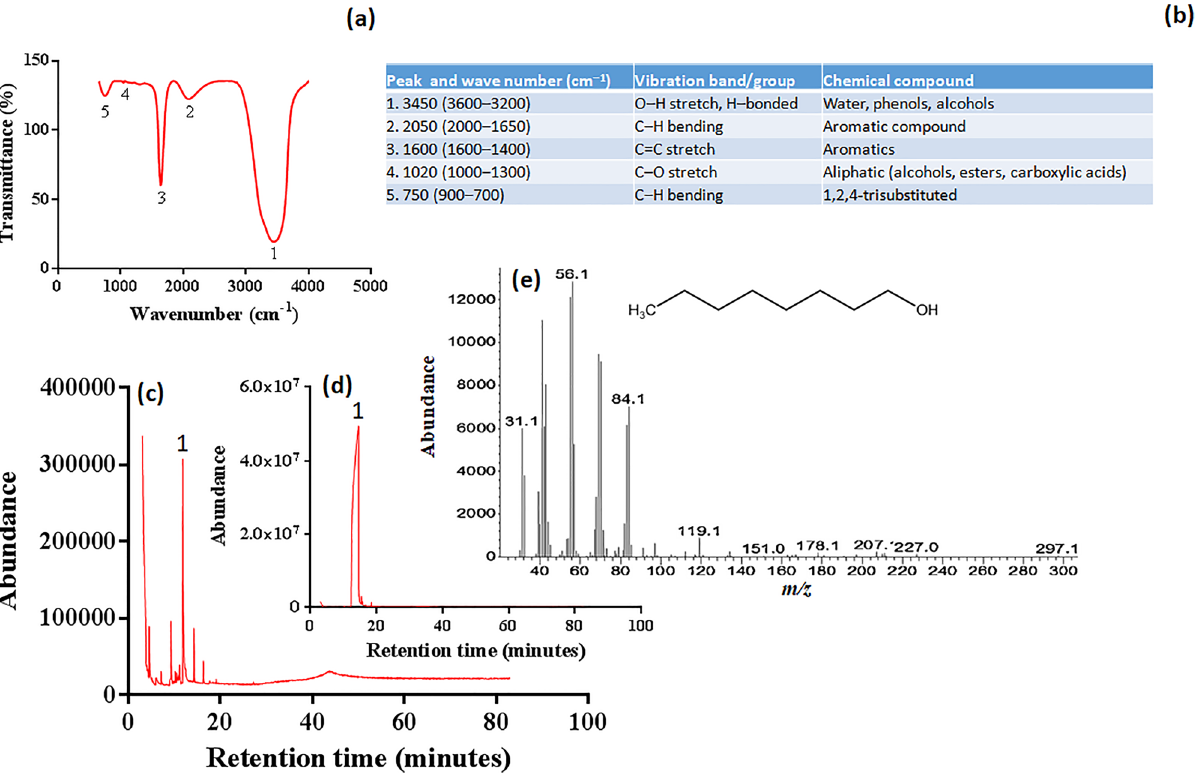
Figure 2. FT-IR and GC–MS analyses of aqueous tea extract (TeaAq). ( a ) FT-IR spectrum, ( b ) IR vibrational band summary, ( c ) gas chromatogram of TeaAq, ( d ) gas chromatogram of 1-octanol standard and ( e ) mass fingerprint of 1-octanol